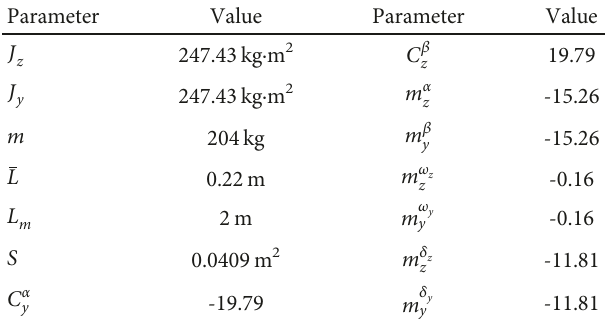
Table 1: Aerodynamic parameters of the interceptor missile.